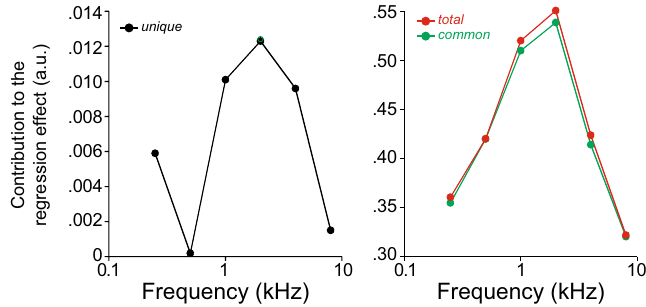
Figure 6. Contribution of cochlear regions to WRS/∆WRS. Commonality coefficients were computed to determine the unique and common effects across all predictors to the explained variance (R-squared) in the regression